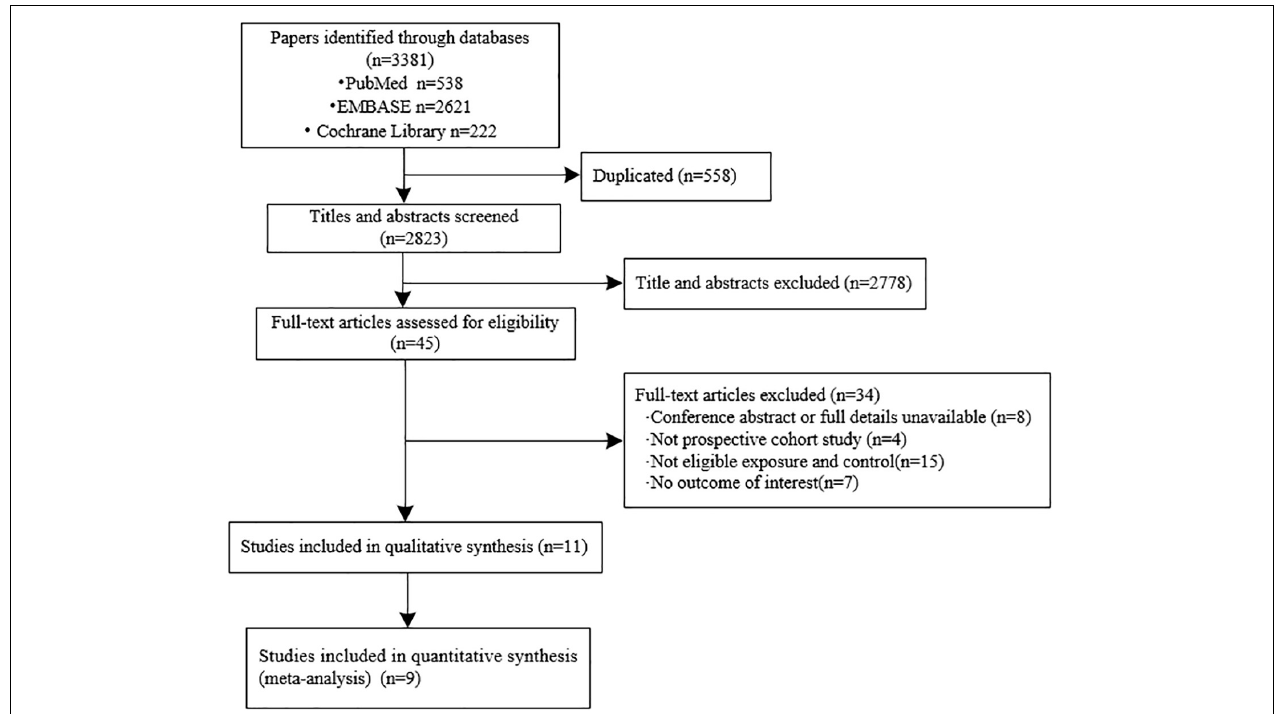
FIGURE 1 | Flow chart for the literature search, study selection, and reasons for